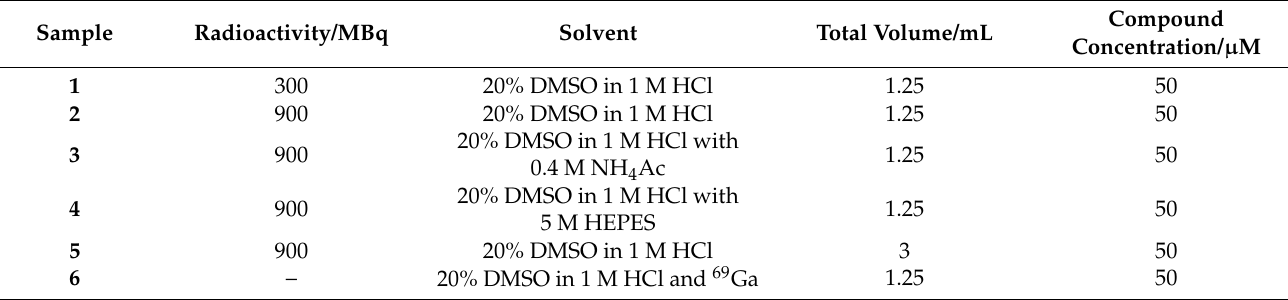
Table 3. Incubation of cagedAZD5438 with the beta plus emitter 68 Ga under varying conditions (samples 1–6; in samples 3 and 4, the acidic pH was buffered with ammonium acetate and HEPES). Each sample was analyzed twice. As positive controls, after incubation with 68 Ga, samples 1–6 were irradiated with UV light, showing uncaging of cagedAZD5438. As a negative control, a solution of the non-radioactive 69 Ga was employed (sample 6). Incubating a solution of AZD5438 under the respective conditions used for samples 1–6 proved the inhibitor AZD5438 to be stable (Figure